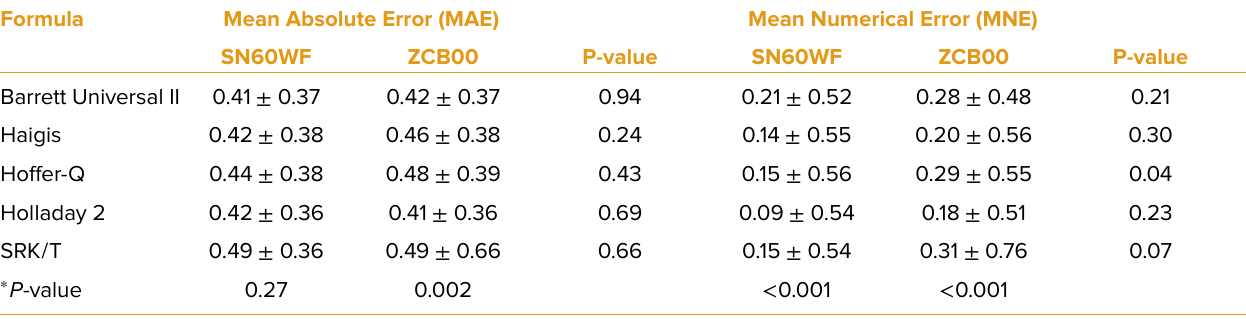
Table 2. Mean absolute error (MAE) and mean numerical error (MNE) for each formula for both SN60WF and ZCB00 lenses. Formula Mean Absolute Error